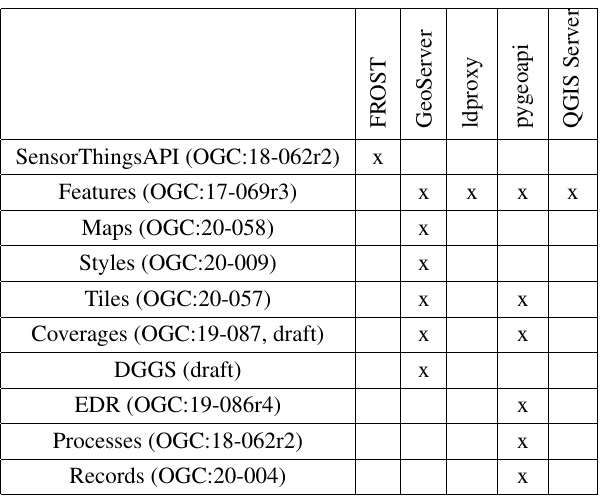
Table 1. Implementations according to conformance